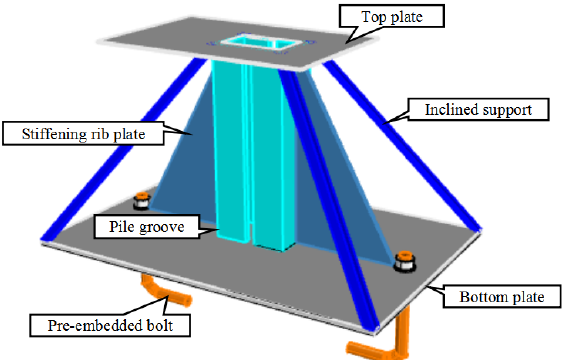
Figure 6. Three-dimensional model diagram of the fixing system of test pile.